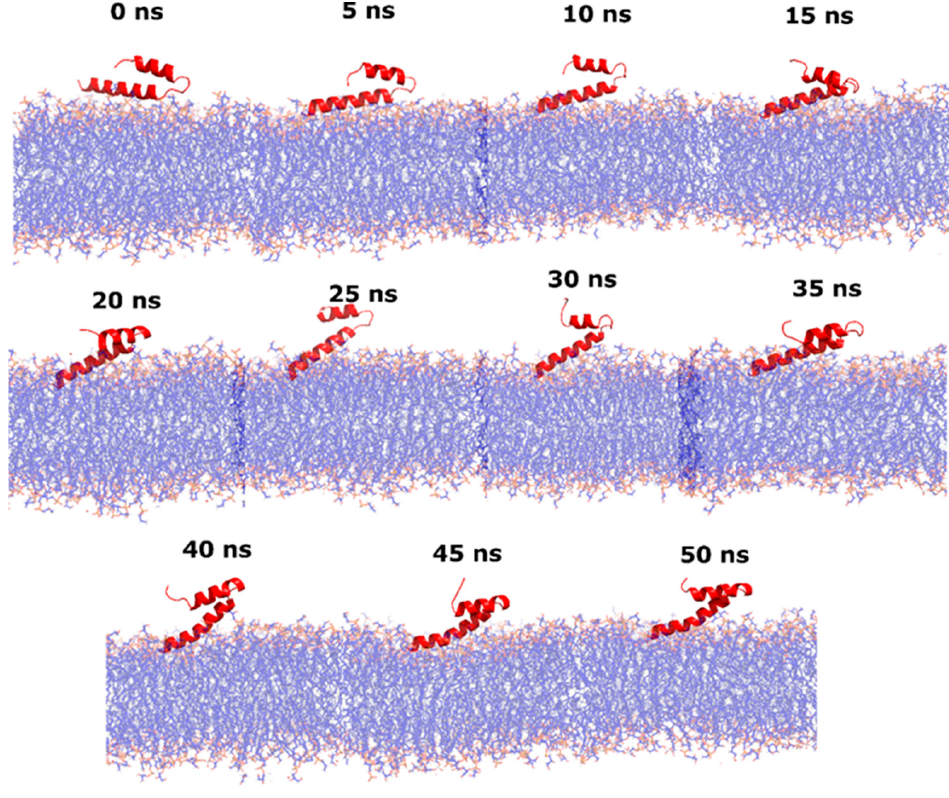
Figure 4. Dynamics of interaction between the ∆ M2 peptide and the model membrane of susceptible Pseudomonas (WTPa) for 50 nanoseconds.